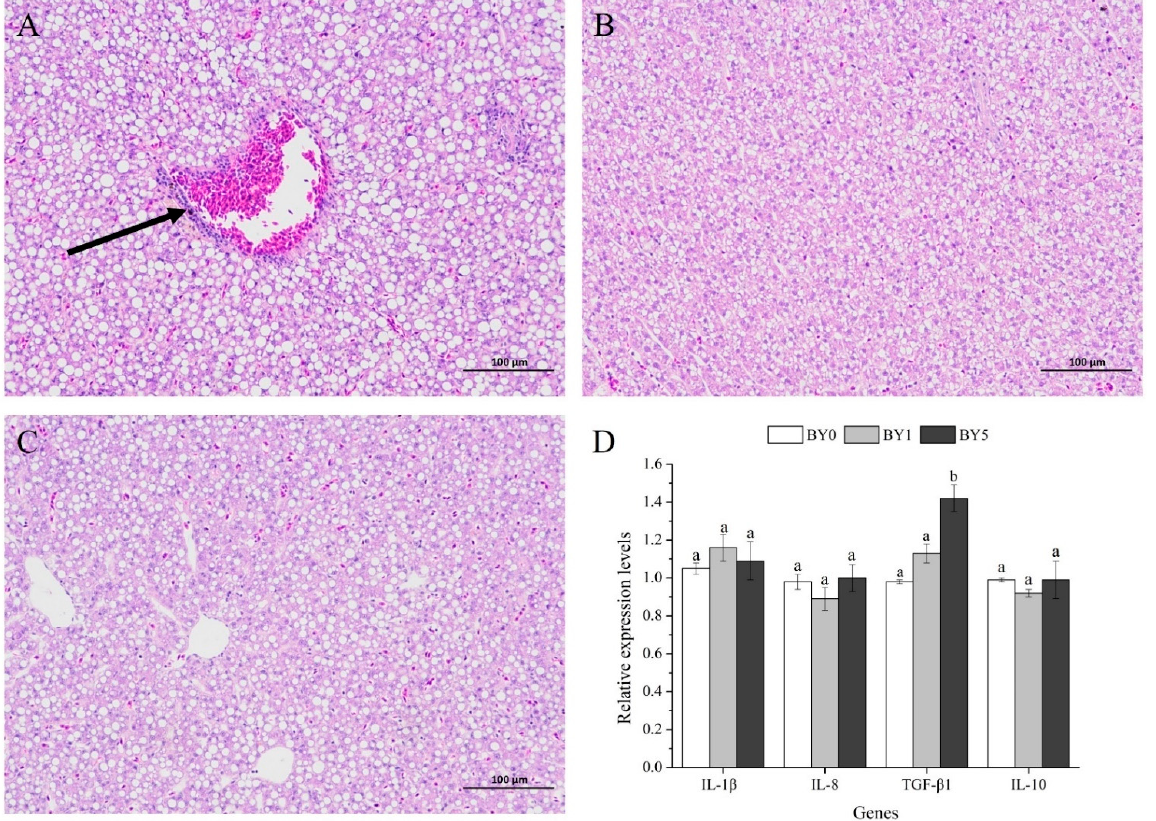
Figure 6. Liver morphology of T. ovatus fed with BY0 ( A ), BY1 ( B ), and BY5 ( C ) diets, and relative expression levels of inflammation-related genes in the liver of fish fed experimental diets ( D ). The black arrow indicates the infiltration of inflammatory cells. Values are presented as mean ± SE ( n = 18). The small letters indicate significant differences at p < 0.05. IL-1 β , interleukin 1 β ; IL-8, interleukin 8; TGF- β 1, transforming growth factor β 1; IL-10, interleukin 10.